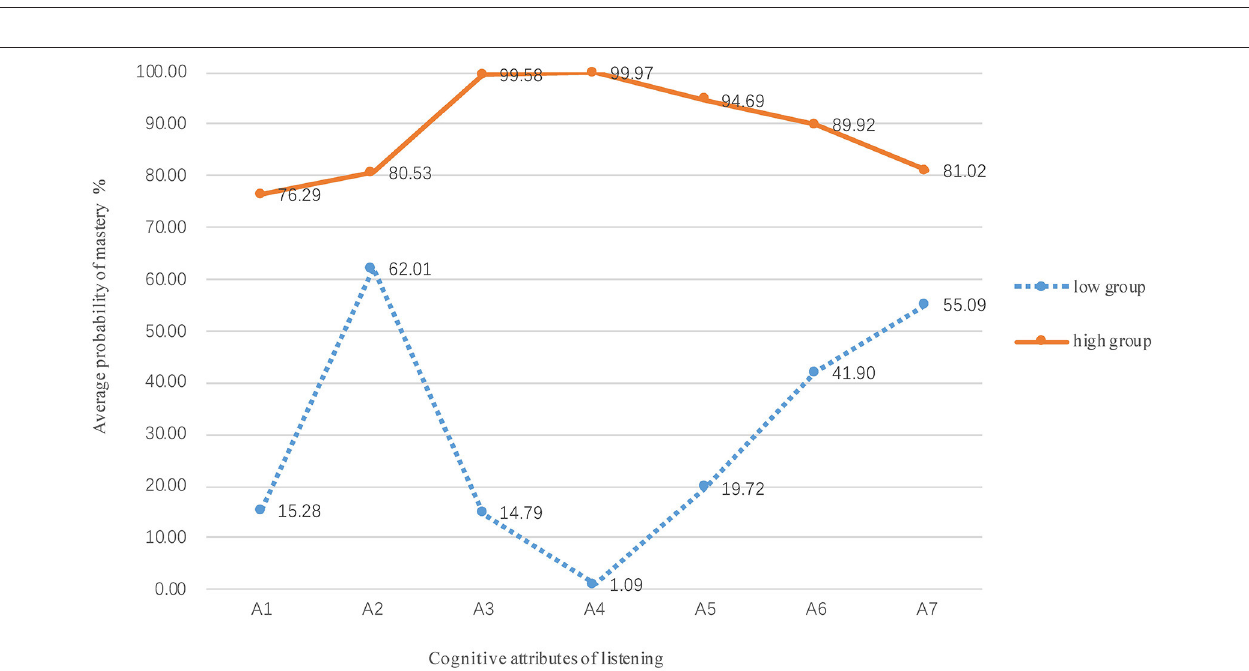
FIGURE 6 | Average mastery probability between high and low